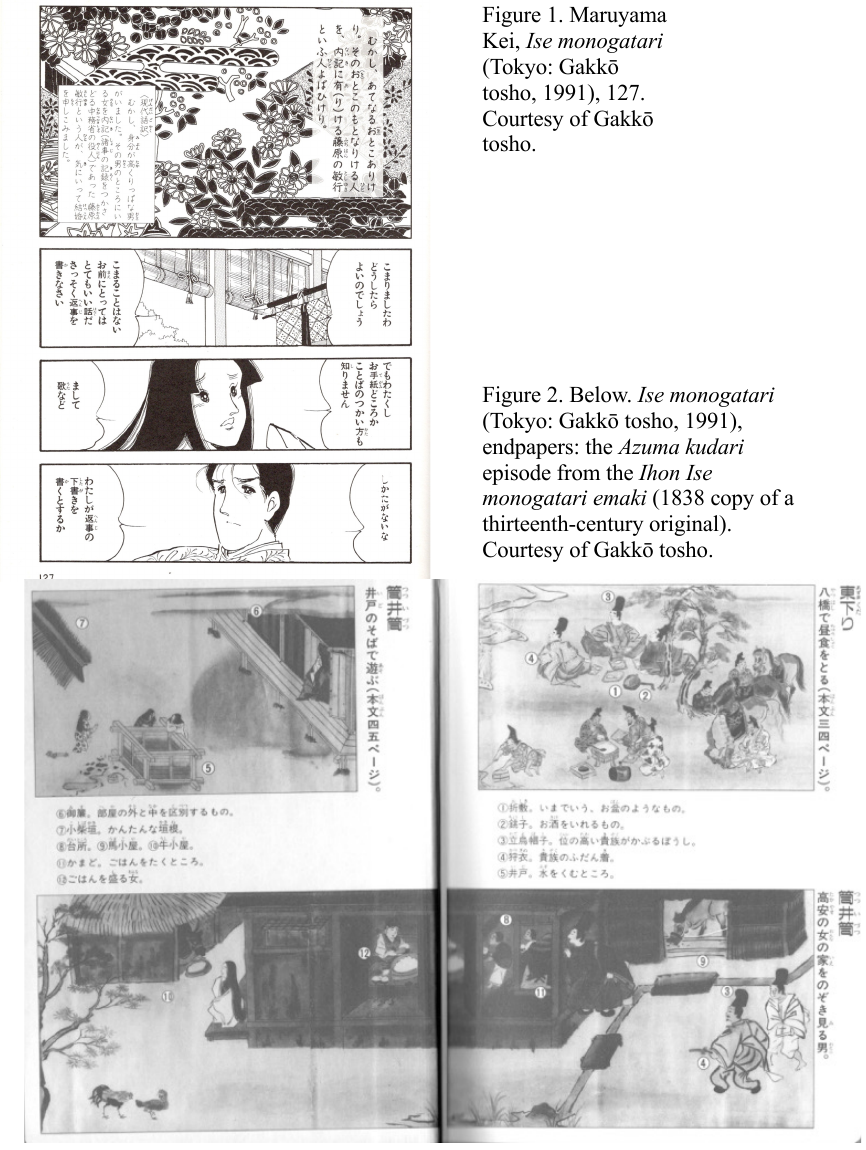
Figure 1. Maruyama Kei, Ise monogatari (Tokyo: Gakkō tosho, 1991), 127. Courtesy of Gakkō